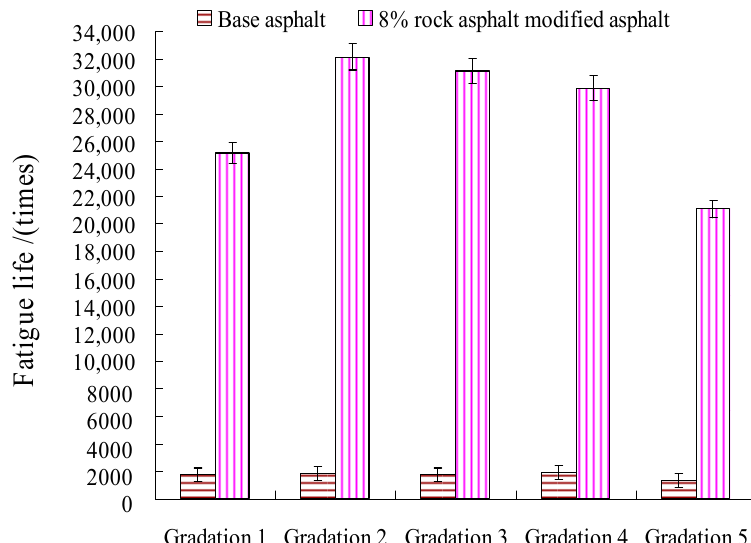
Figure 11. Fatigue life of NS RA-modified asphalt mixtures with different gradations.